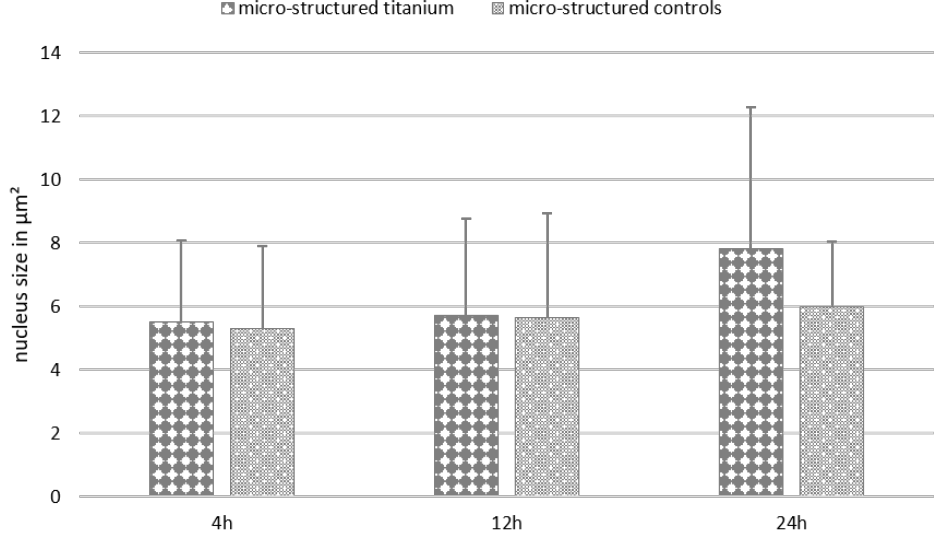
Figure A6. Comparison of the nucleus size after 4, 12 and 24 h of cultivation of microstructured titanium probes with controls. The bars correspond to the mean value, the line on top to the ± standard deviation.